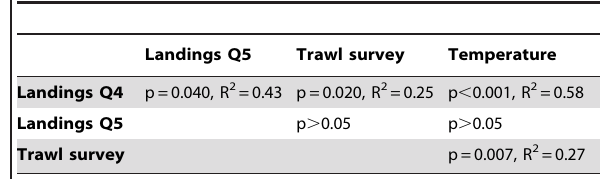
Table 3. Correlation analyses between proxies for spatial patterns of the mackerel represented by Position of 50% Cumulative Landings (Po50%CL) and modeled temperature in the shelf edge